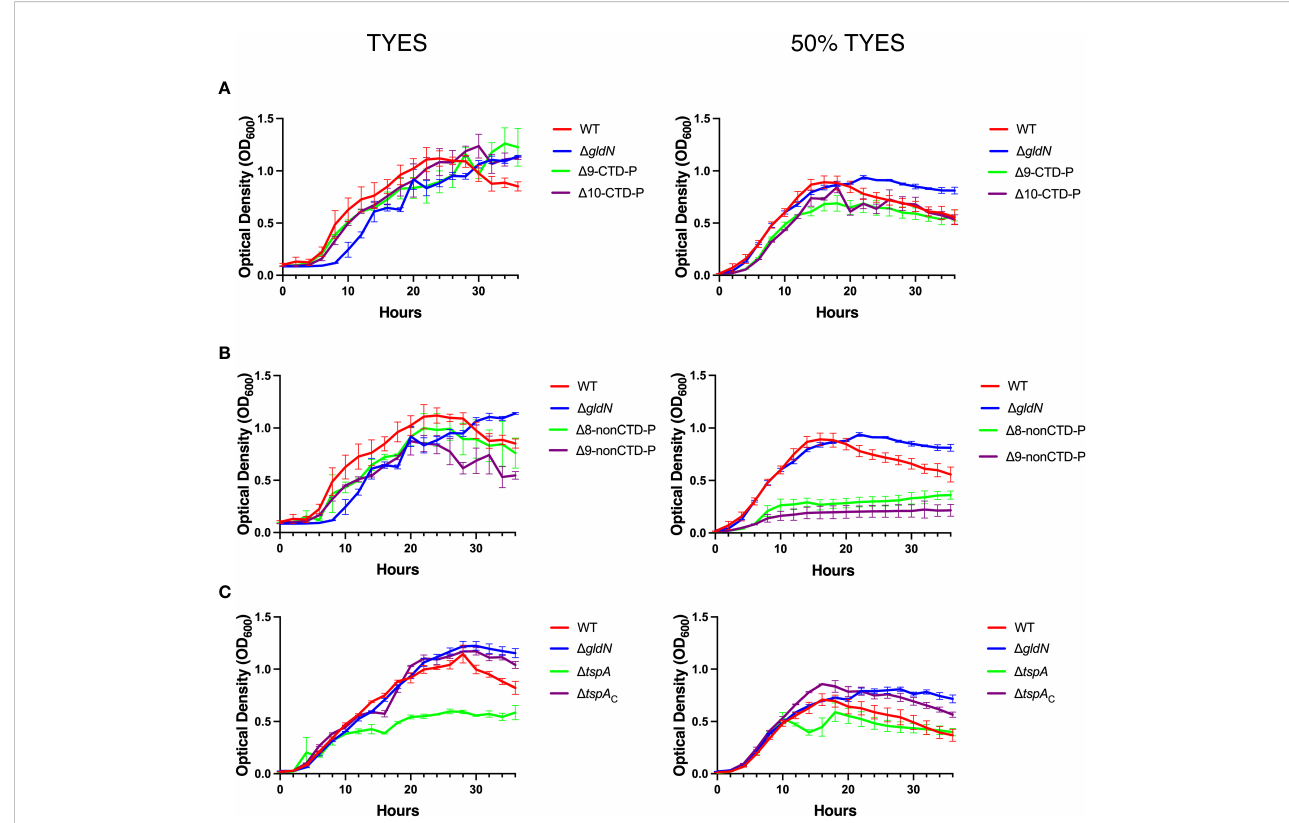
FIGURE 8 Growth curves for wild-type (WT) and mutant F. columnare strains. Cells were grown in TYES medium or 50% TYES medium at 28°C in a 48-well plate for 36 hours. Growth curves were performed in triplicate and error bars indicate standard error of the mean. (A) WT; D gldN ; D 9-CTD-P; D 10-CTD-P. (B) WT; D gldN ; D 8-nonCTD-P; D 9-nonCTD-P. Signi fi cant differences in bacterial cell density were observed in 50% TYES for D 8-nonCTD-P and D 9- nonCTD-P compared to the WT ( P <0.0001). (C) WT; D gldN ; D tspA , and D tspA complemented with pHM22 ( D tspA c ). Signi fi cant differences in bacterial cell density were observed in TYES for D tspA compared to the WT ( P <